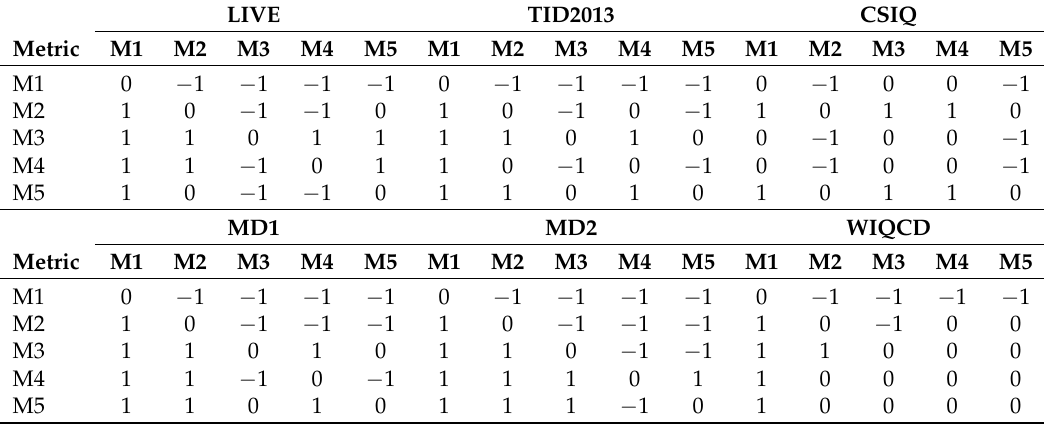
Table 6. Statistical significance comparison of M1, M2, M3, M4, and M5 with t -test between